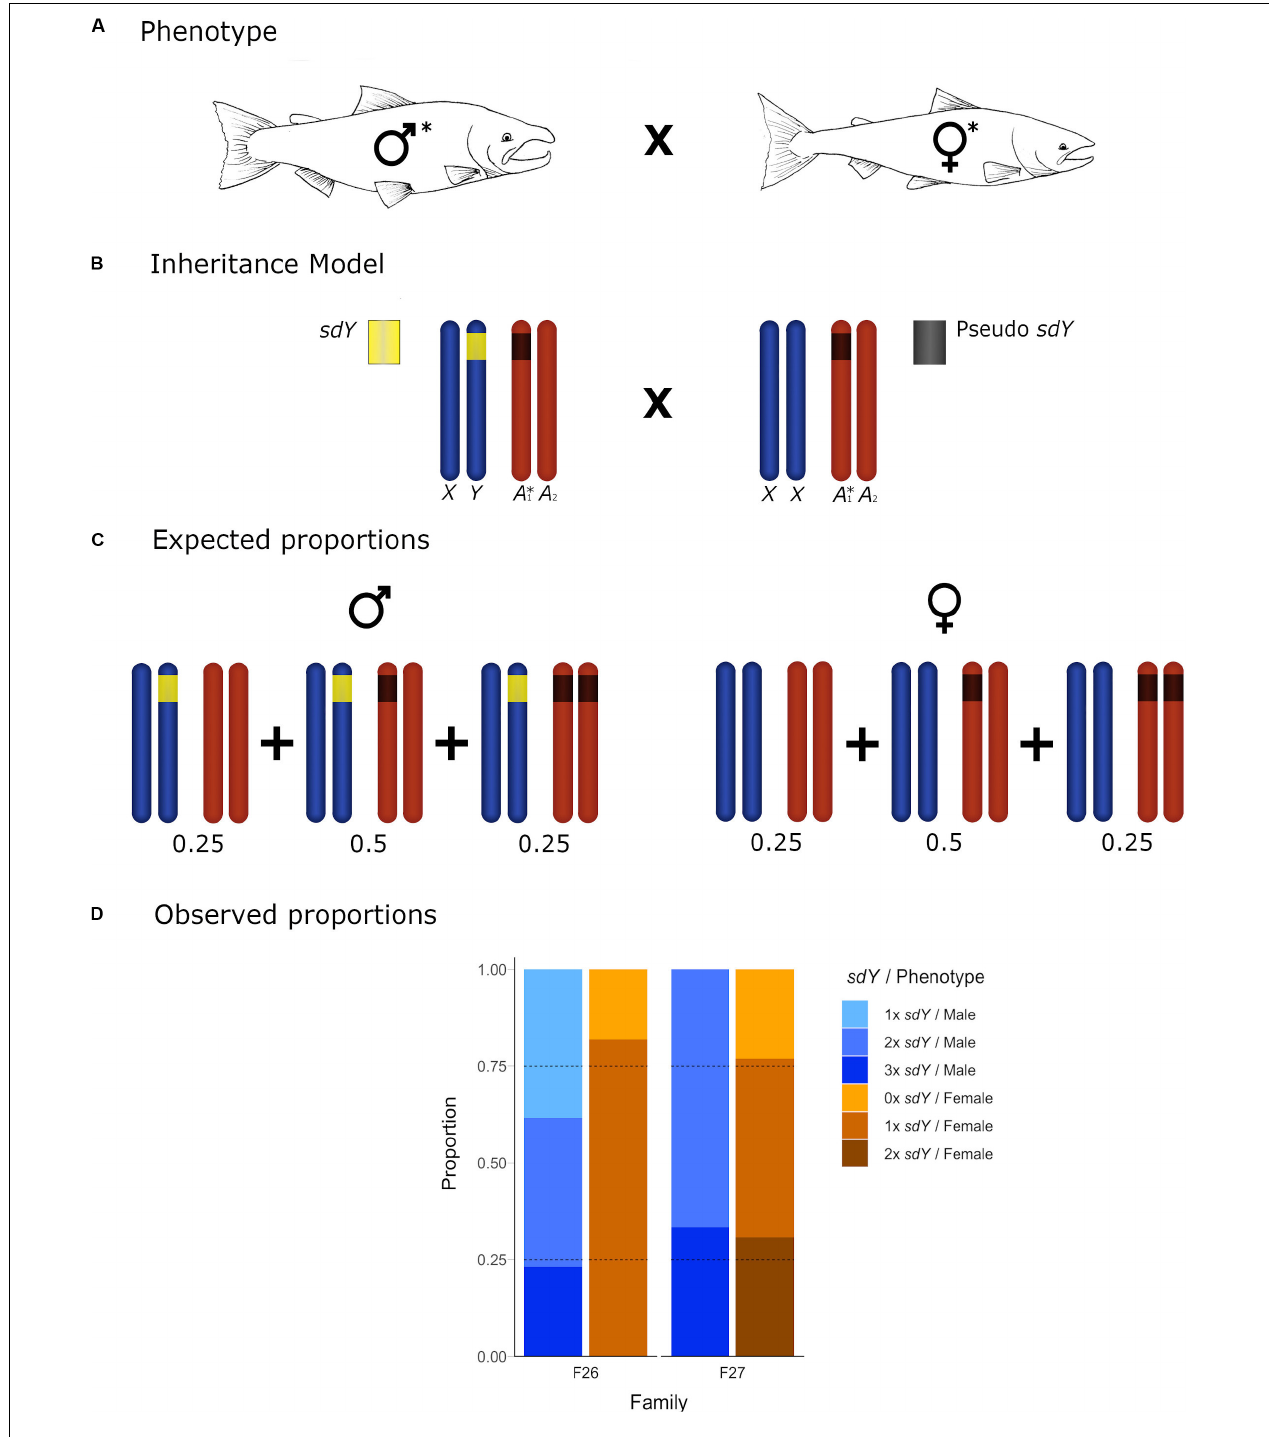
FIGURE 4 | Conceptual diagram showing the inheritance model and the observed frequencies for the offspring of crosses with both parental individuals carrying an sdY pseudocopy. (A) Cross between a 2 × sdY phenotypic male and a 1 × sdY discordant female: Both affected parental individuals are denoted with an asterisk. (B) Conceptual diagram showing the inheritance model at a chromosome level. Sex chromosomes and autosomes are represented in dark blue and dark orange, respectively. (B) 2 × sdY male (left) carrying a copy of the sex determining sdY gene (yellow) in the Y chromosome and the extra autosomic copy (dark gray) in heterozygosis. Discrepant 1 × sdY phenotypic female (right) carrying an sdY autosomic pseudocopy (dark gray) in heterozygosis. (C) Males and females expected proportions for the different sdY genotypes (1–3 × ). (D) Offspring observed proportions for the affected families of 1–3 × sdY males and 0–2 × sdY females: light blue, blue, dark blue, light orange, orange, and dark orange, respectively. Dotted lines represent the sdY genotype expected frequencies.